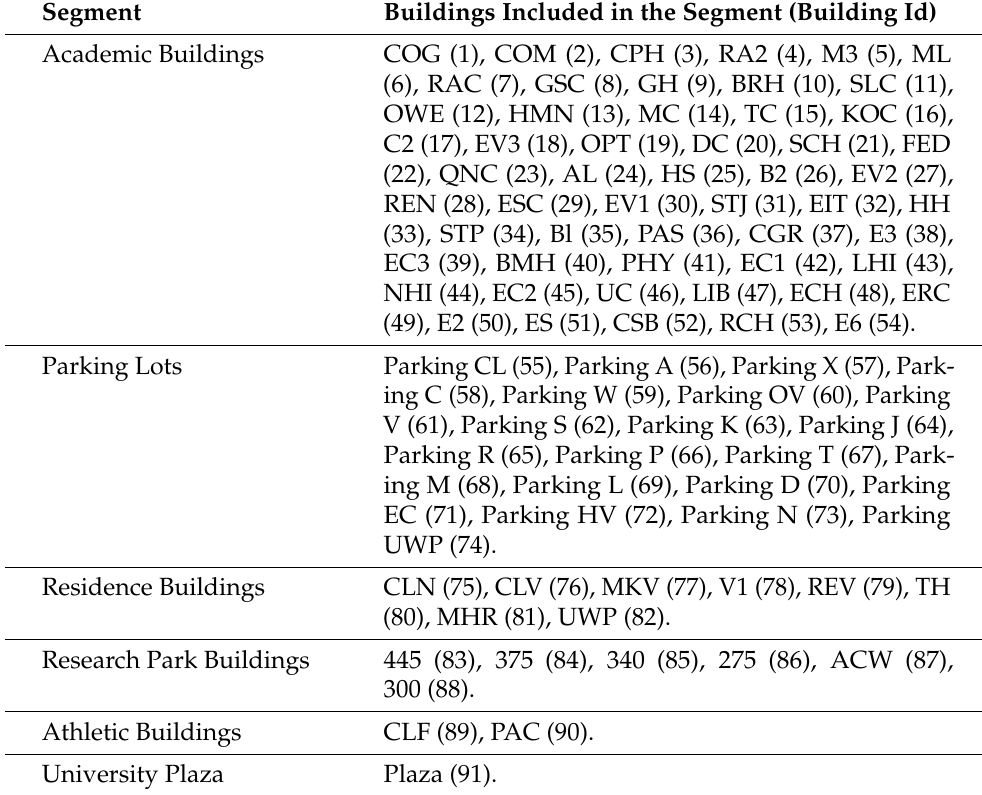
Table 2. The functional classification for all facilities in the